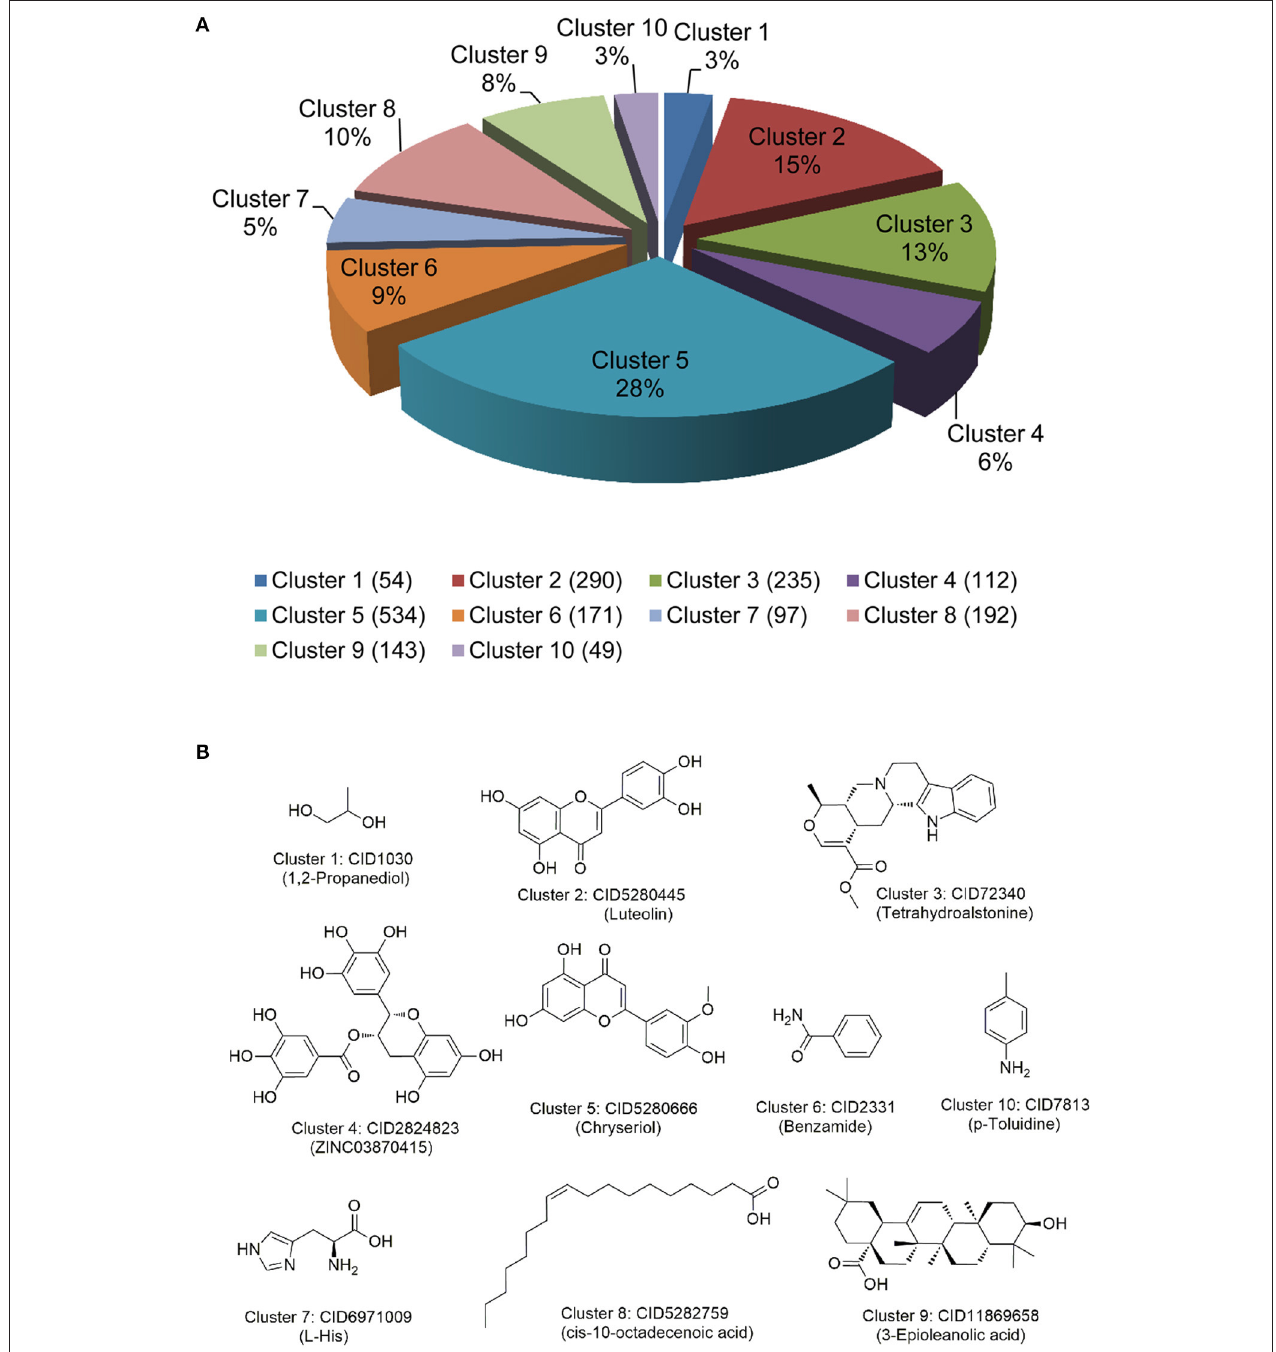
FIGURE 4 | Chemical diversity analysis of natural products targeting aging-associated proteins. (A) Chemical structure clustering of 1,877 natural products via FCFP_6 fingerprint; (B) The representative structures of 10 cluster centers during chemical structural clustering analysis.